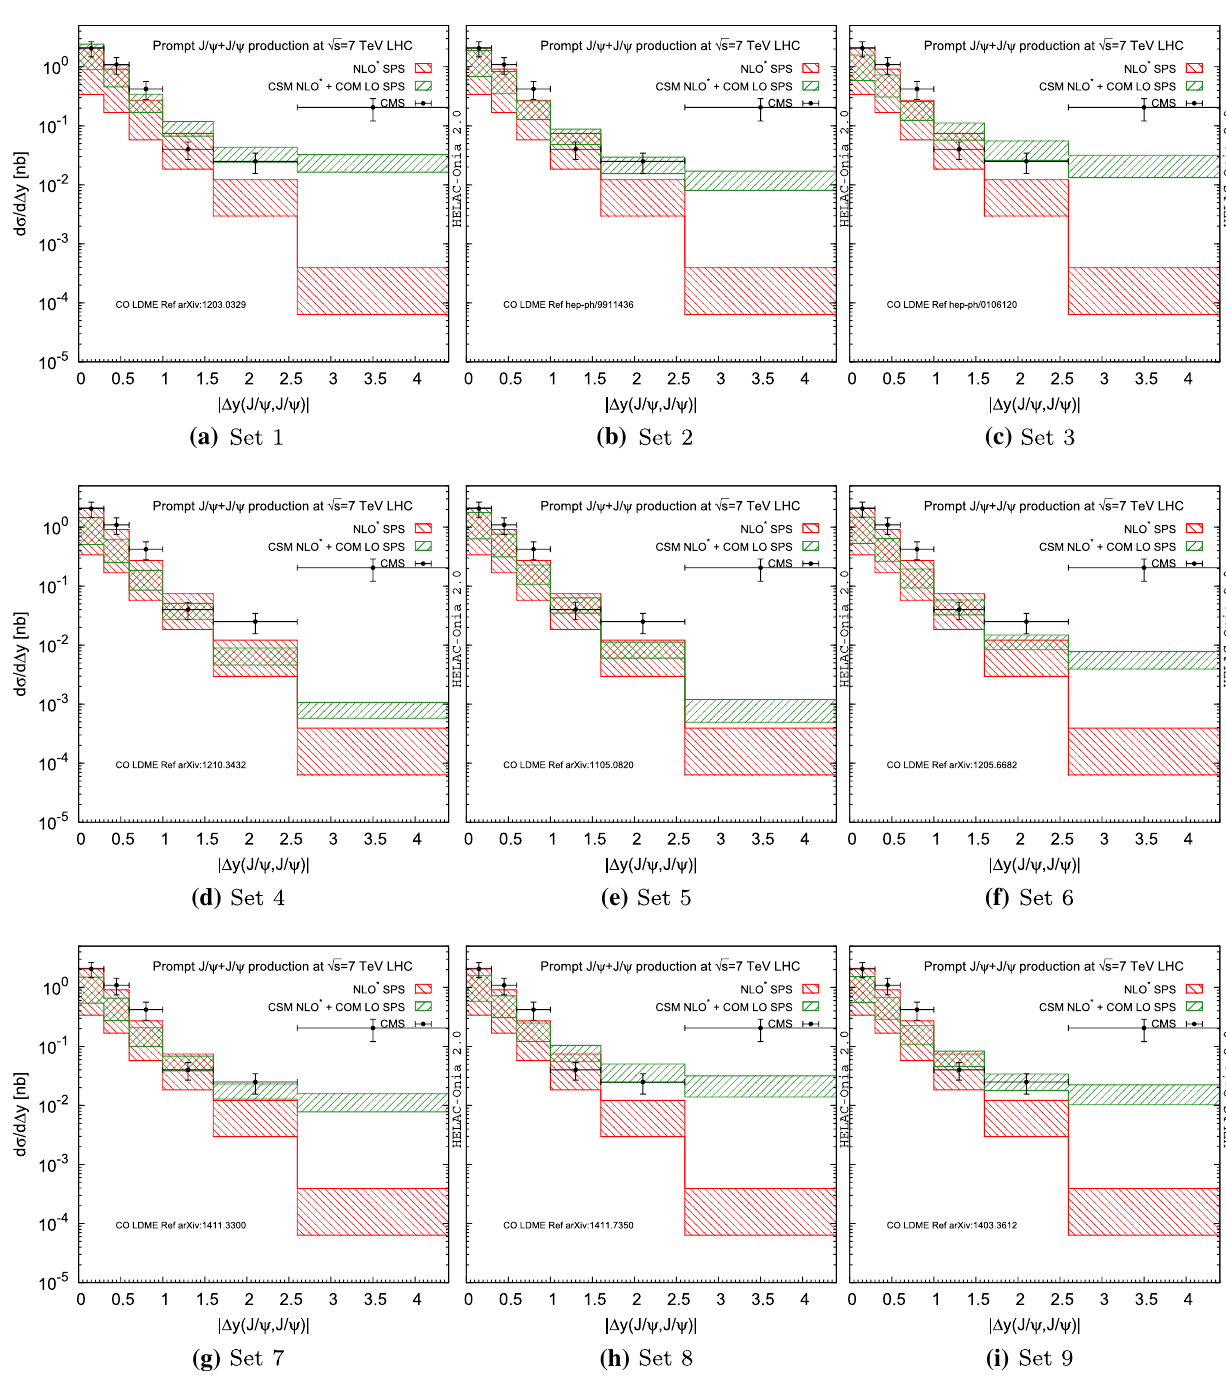
√ s = 7 TeV acceptance [21]